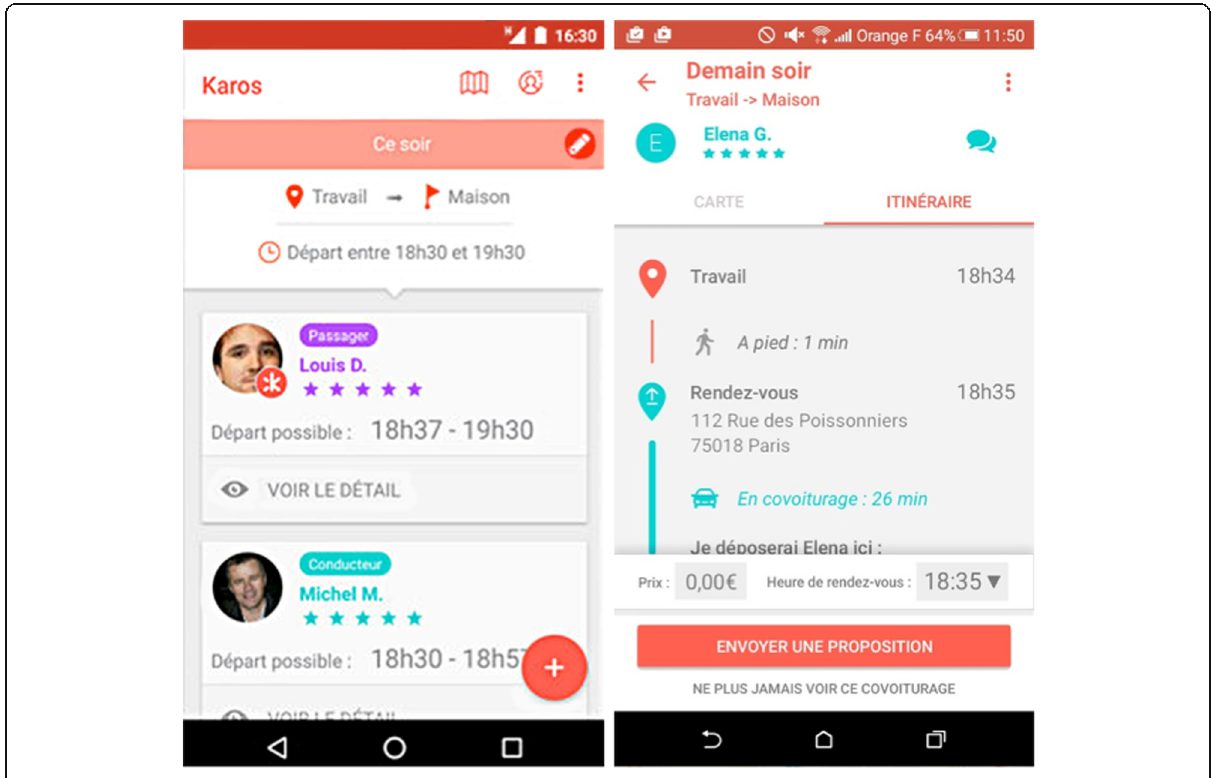
Fig. 2 Screenshots of the smart carpooling app (2016)© Karos